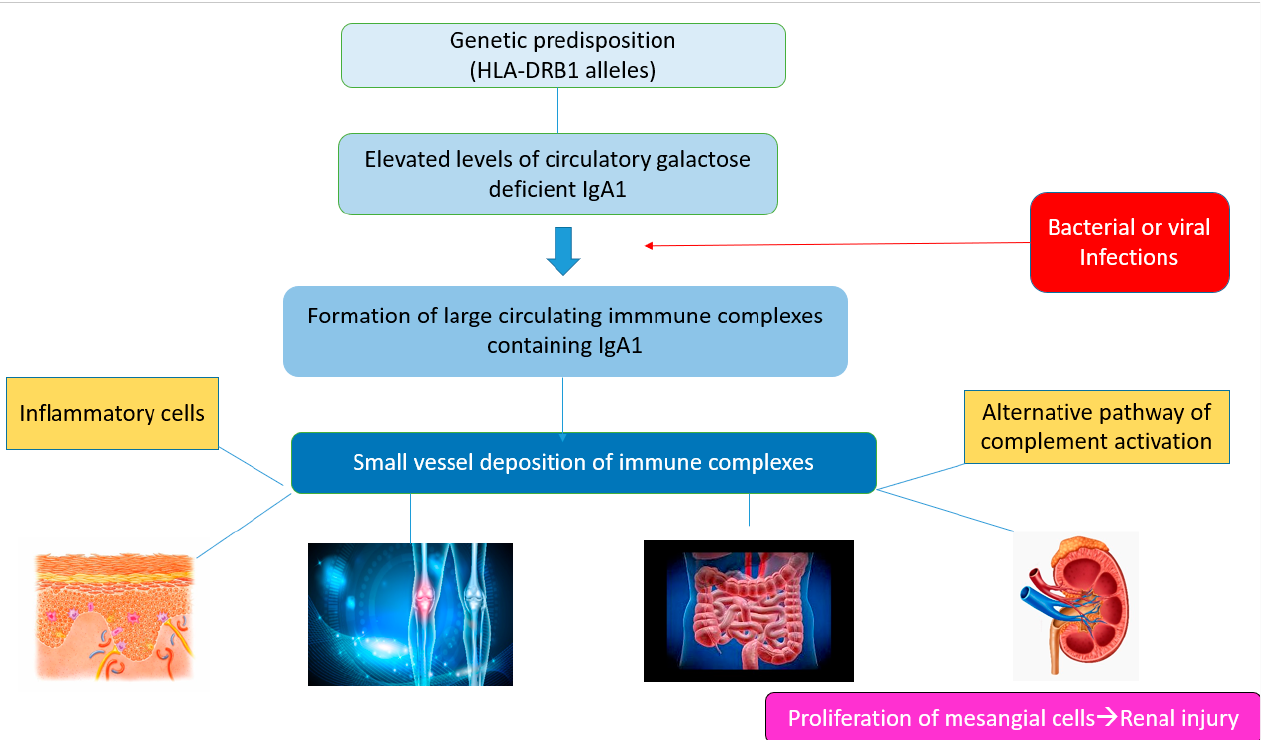
Figure 3. Schematic representation of the main pathogenetic steps of IgA vasculitis.